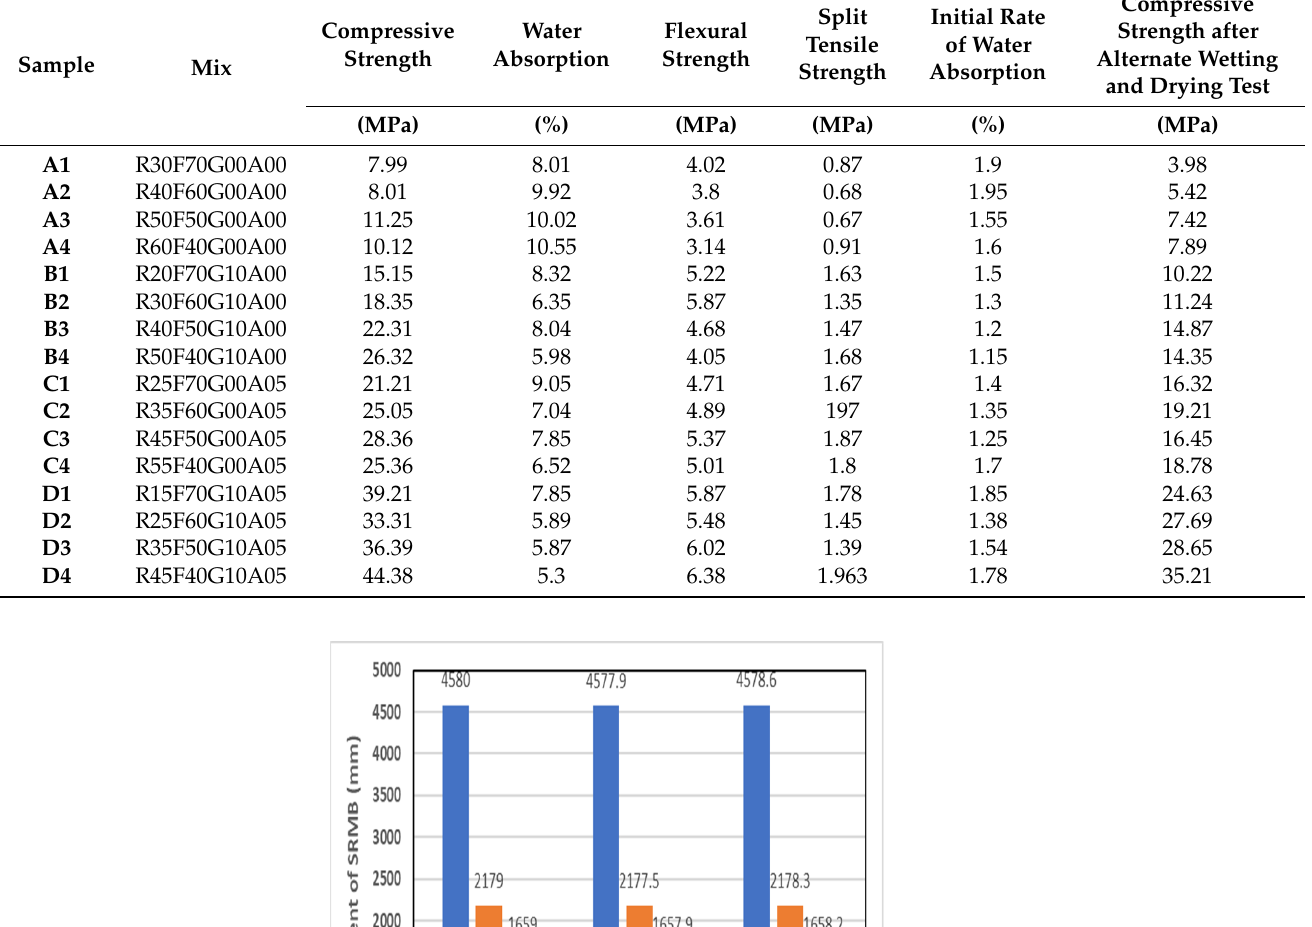
Table 14. Mechanical strength and water absorption of red mud bricks after 90 days.